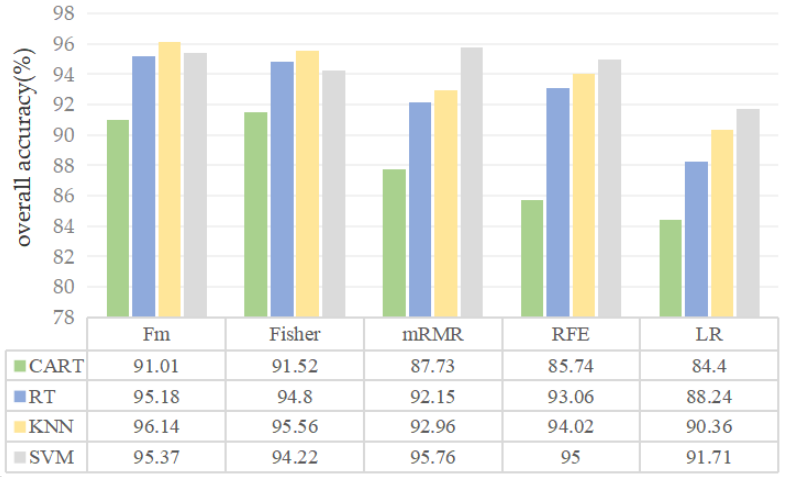
Figure 6. The optimal accuracy of four features with different classifiers was